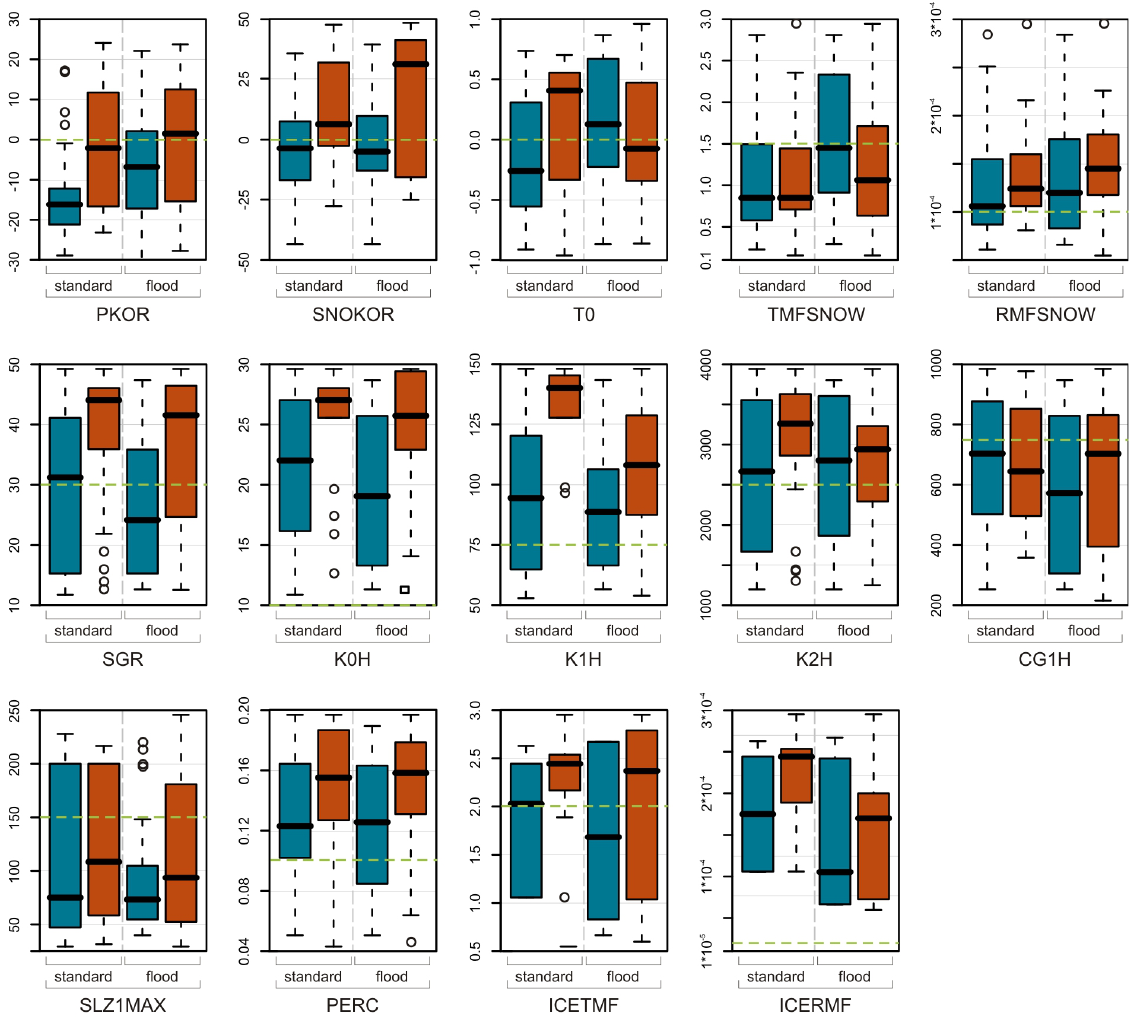
Fig. 3. Box plots for calibrated tuneable model parameters (for acronyms see Table 1) from 49 representative Northern Alpine (blue boxes, Viviroli et al., 2009b) and 23 Southern Alpine catchments (red boxes) for standard and flood calibration mode within the maximum calibration range. The initial value is indicated by a horizontal dashed green line. Circles denote outliers (distance from upper or lower quartile is greater than 1.5times the quartile range; Tukey,